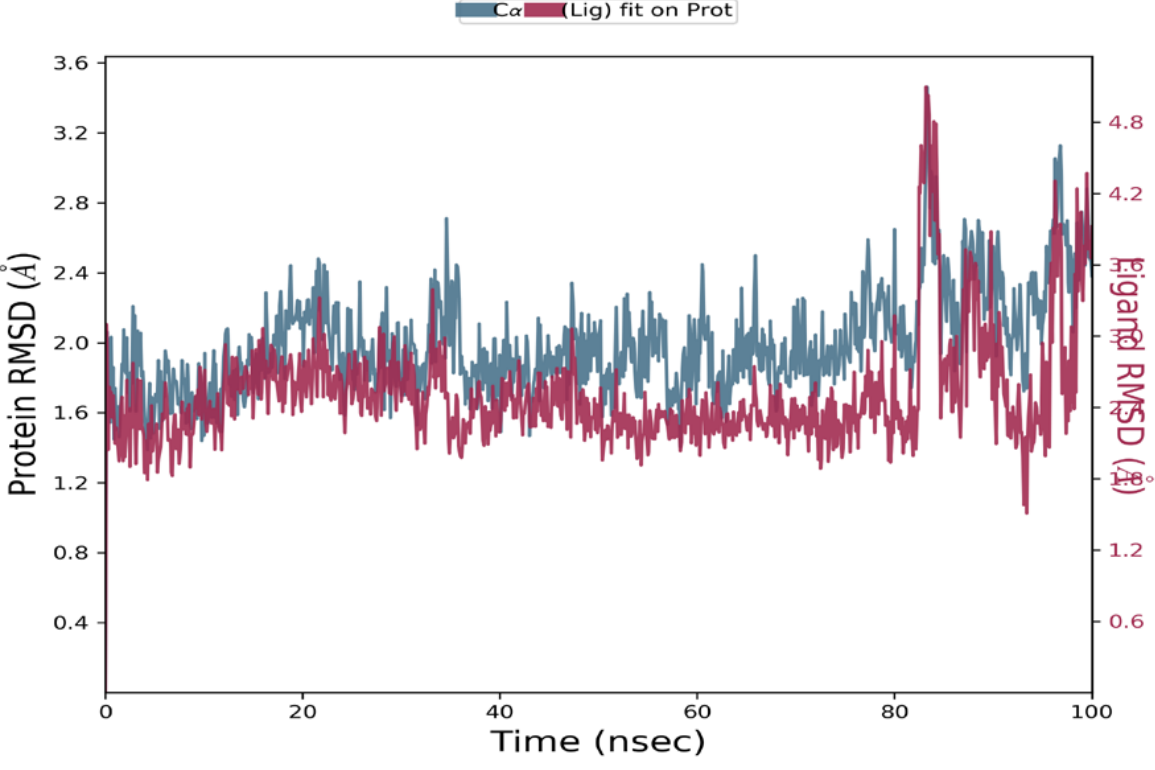
Figure 13. The RMSD plot for molecular dynamics simulation of MM137 and CHK1: RMSD values of the ligand MM137 complexed with CHK1 recorded during the MD simulation for 100 ns.